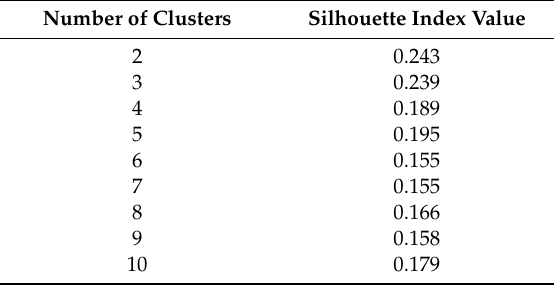
Table 3. Silhouette index